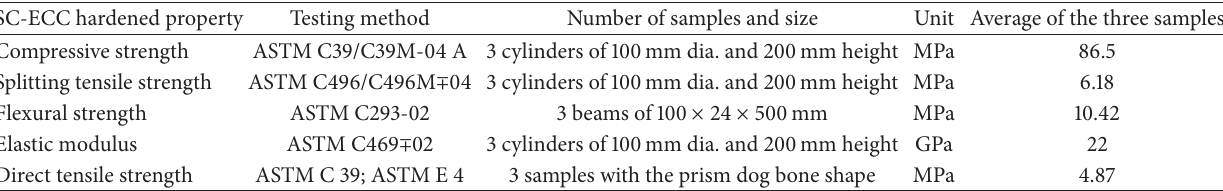
Table 4: Properties of hardened ECC.